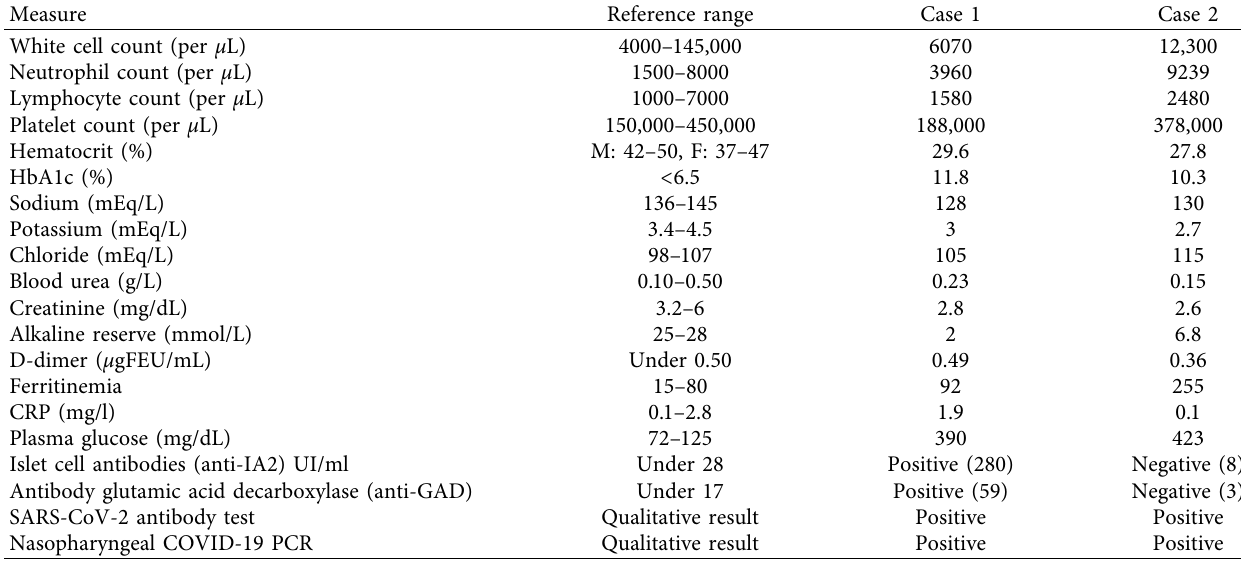
Table 1: The main biological assessments of the 2